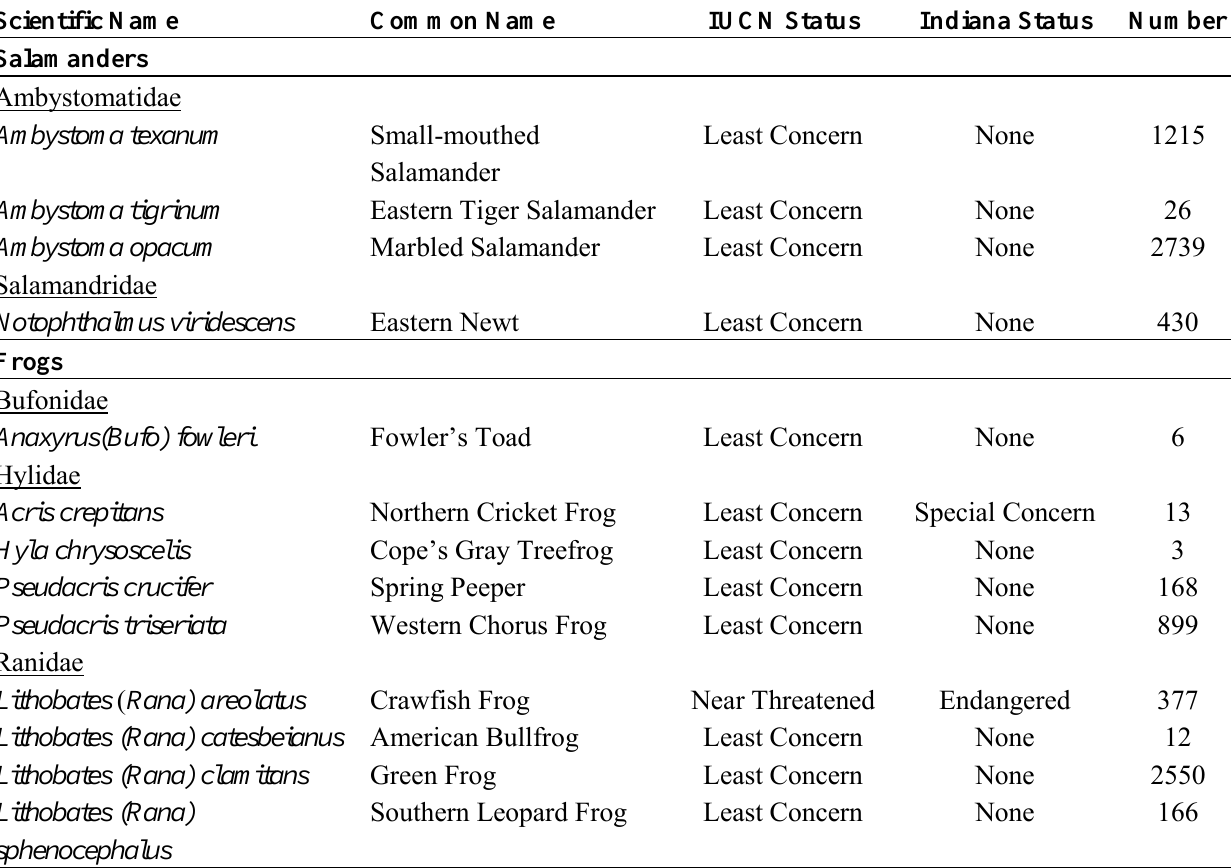
Table 1. Amphibian species and numbers (adults and juveniles)